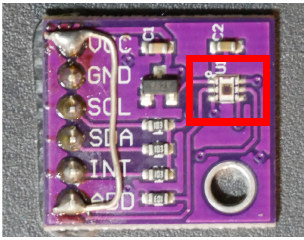
Figure 2. View of OPT3001 illuminance sensor mounted on PCB (sensor in red frame).